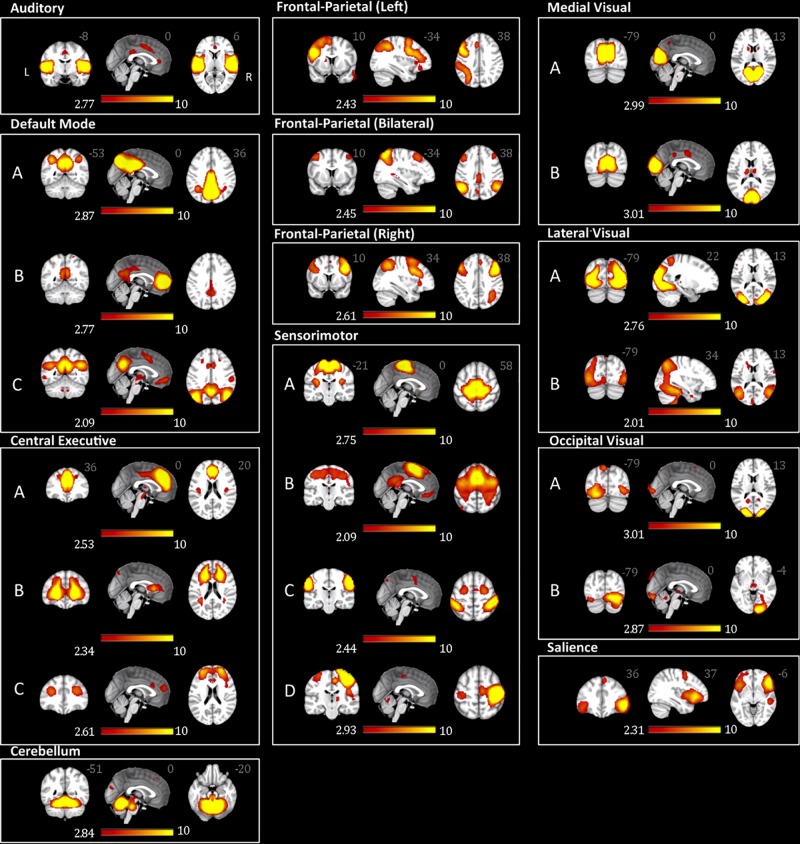
Adolescents and young adults resting-state networks. The networks were obtained using probabilistic ICA on all participants as implemented in MELODIC. The figure depicts the 22 components (from the 75 ICs of the group ICA) selected for subsequent analysis based on the Pearson spatial correlation with previously defined resting-state networks (Smith et al., 2009 19620724) and visual inspection. These 22 components corresponded to 10 distinct resting-state networks. The resting-state networks are represented as z-scores.